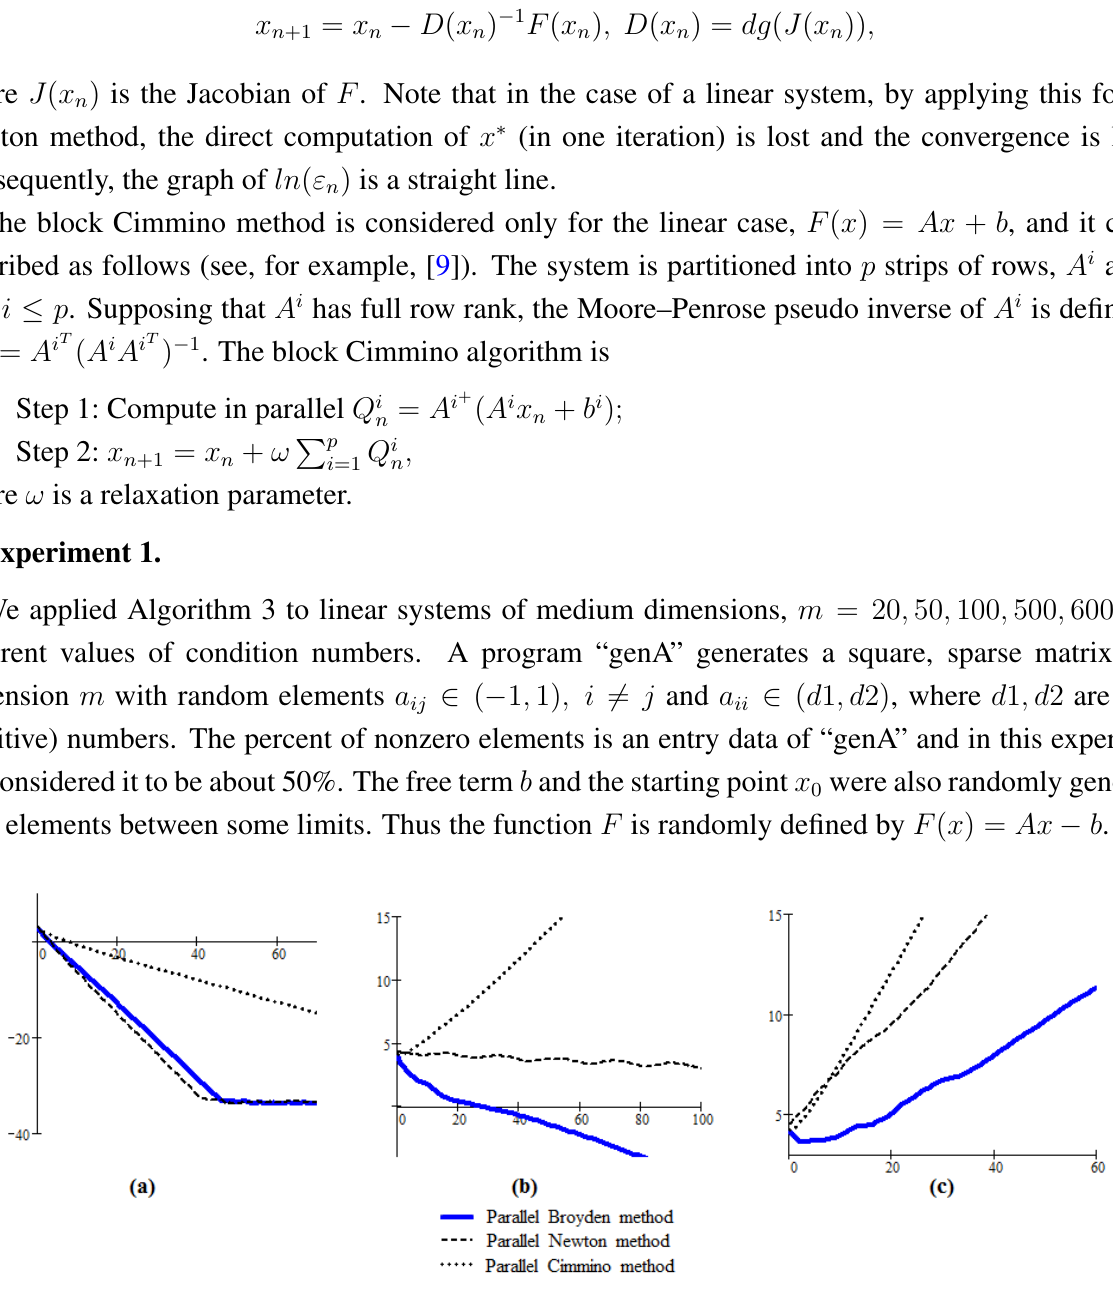
) generated by Algorithm 3, parallel Newton method and Figure 1. The graphs of ln ( ε n parallel Cimmino method in the linear case; ( a ) system well conditioned; ( b ) system medium conditioned; ( c ) system poorly